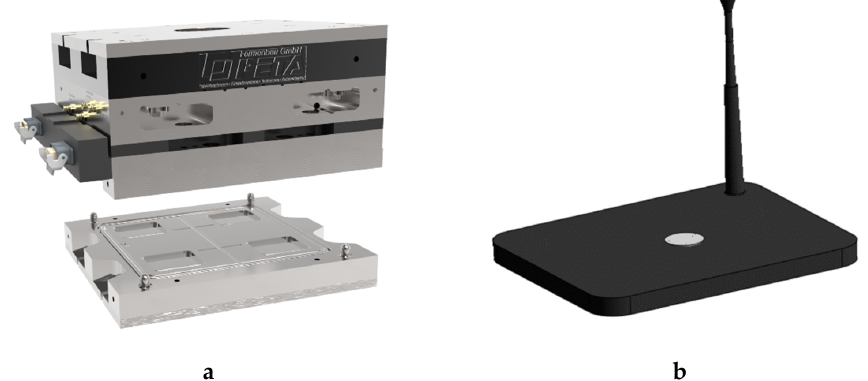
Figure 2. ( a ) 4-cavities-mold with a cold runner system by PETA Formenbau GmbH used for manufacturing injection-molded rubber parts; ( b ) mechanical testing of the curatives conducted by means of dynamic-mechanical analysis (DMA) and compression set analysis with samples taken from the marked position.